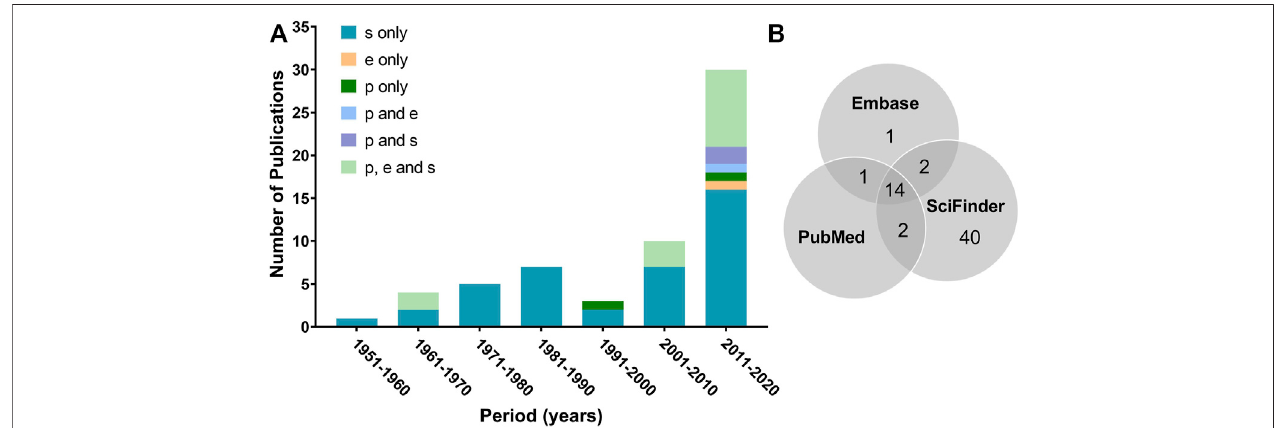
FIGURE 2 | Total number of publications by year of publication (A) and by database (B) . Abbreviations: s, SciFinder; e, Embase; p, PubMed. Categories are color coded depending on fi ndings in one de fi ned database or entries found in several